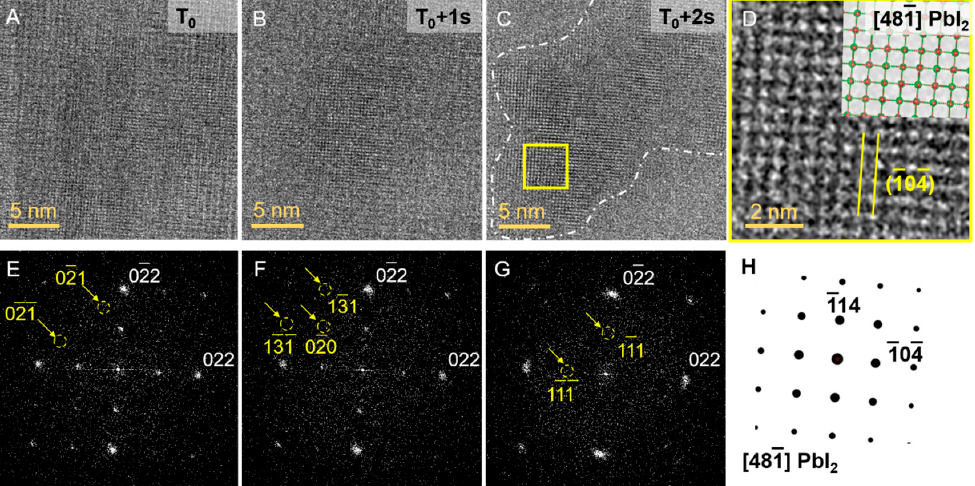
Figure 2. Structural evolution of a BA 2 FAPb 2 I 7 sheet under the electron beam. ( A – C ) ABSF-filtered HRTEM images obtained at T 0 , T 0 +1 s and T 0 +2 s. The exposure time of each frame is 200 ms. The crystalline region in ( C ) is outlined by a white line. ( D ) Enlarged HRTEM image of the boxed region in ( C ). Inset is the [481] structural projection of R3m PbI 2 (Pb: green; I: red). ( E – G ) Corresponding FT of HRTEM images shown in ( A – C ) respectively. The yellow arrows and dot circles mark the disappeared spots during the electron irradiation. The index is based on perfect structure of BA 2 (MA / FA)Pb 2 I 7 solved at 310 K. ( H ) Simulated kinematical selected-area electron diffraction (SAED) pattern of [481] PbI 2